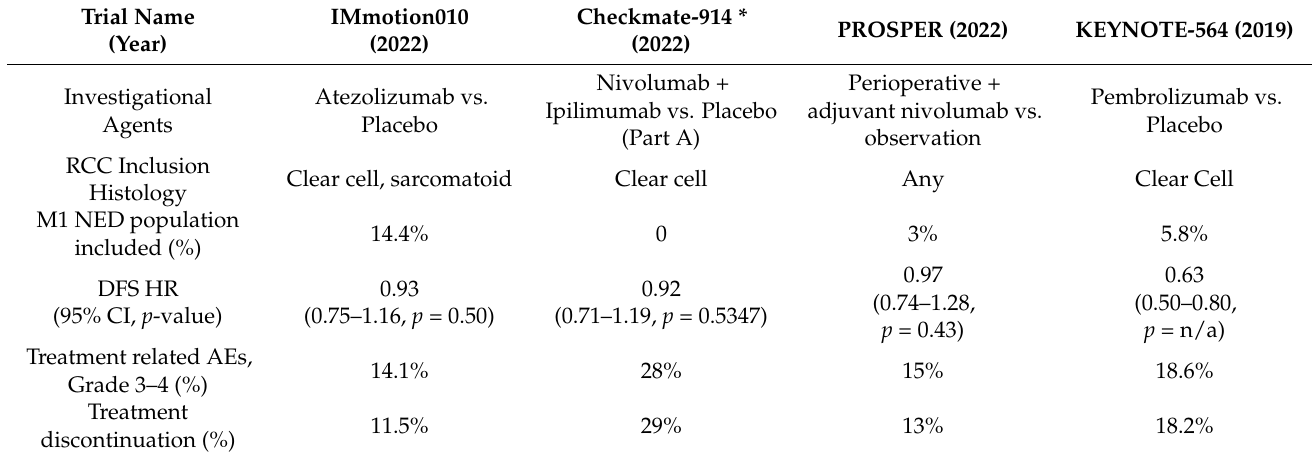
Table 2. Completed Adjuvant Phase 3 Trials with Immune Checkpoint Inhibitors in